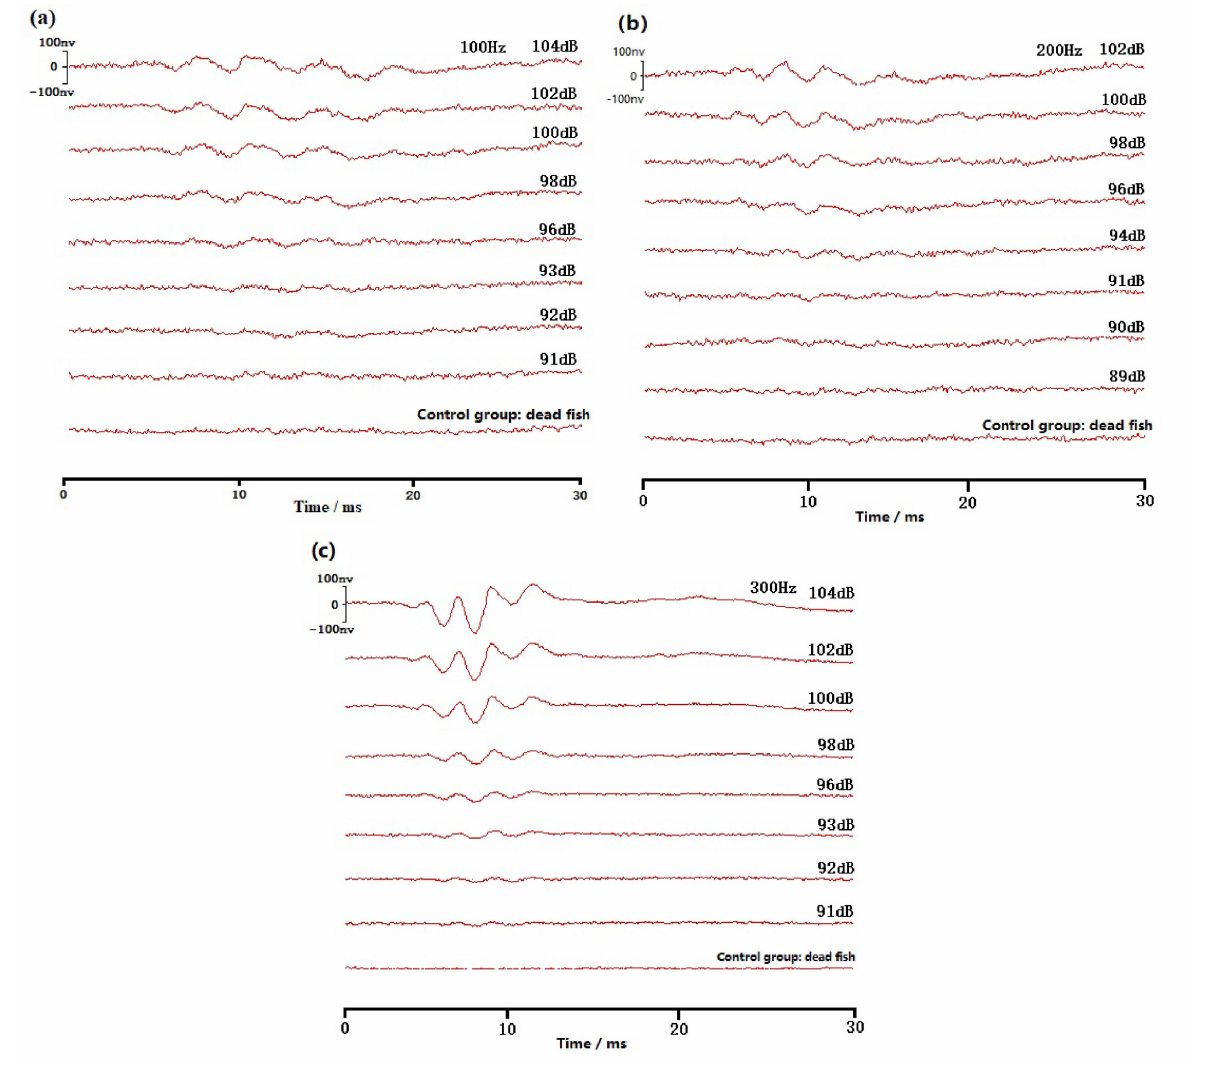
FIGURE 3 Schematic diagram of the wild yellow grouper ABR waveform. (A) Schematic diagram of 100Hz; (B) Schematic diagram of 200Hz; (C) Schematic diagram of